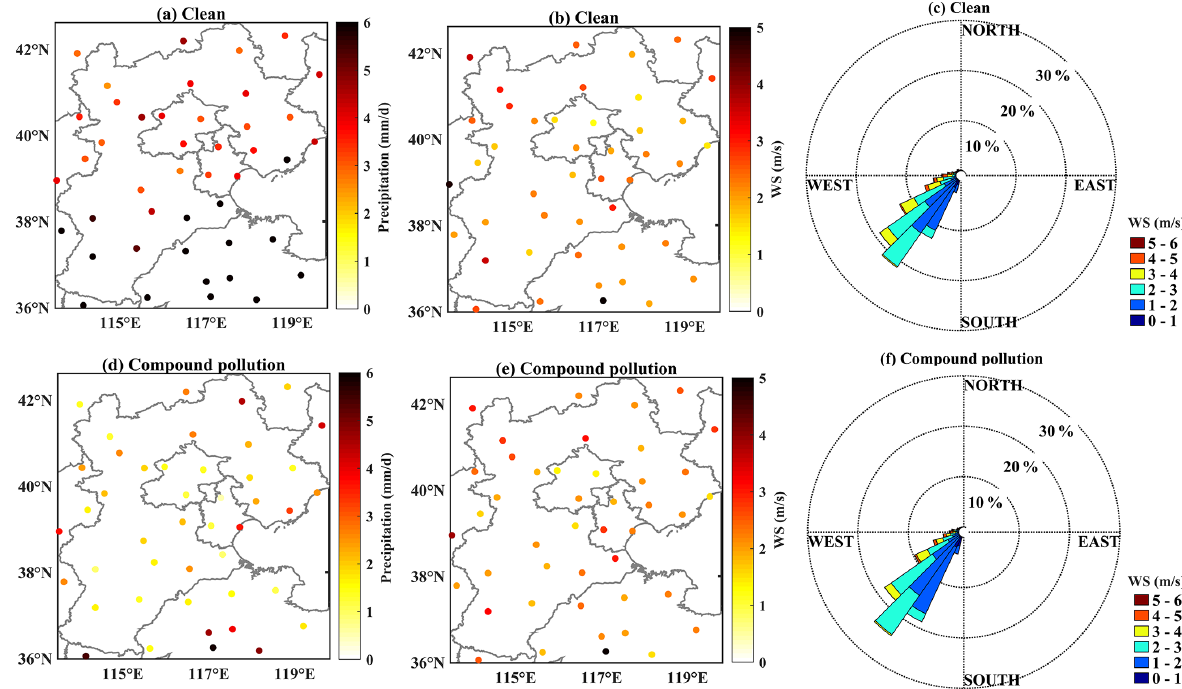
Figure 12. Precipitation, WS and WD during clean and compound pollution periods under Type 1 over BTH.